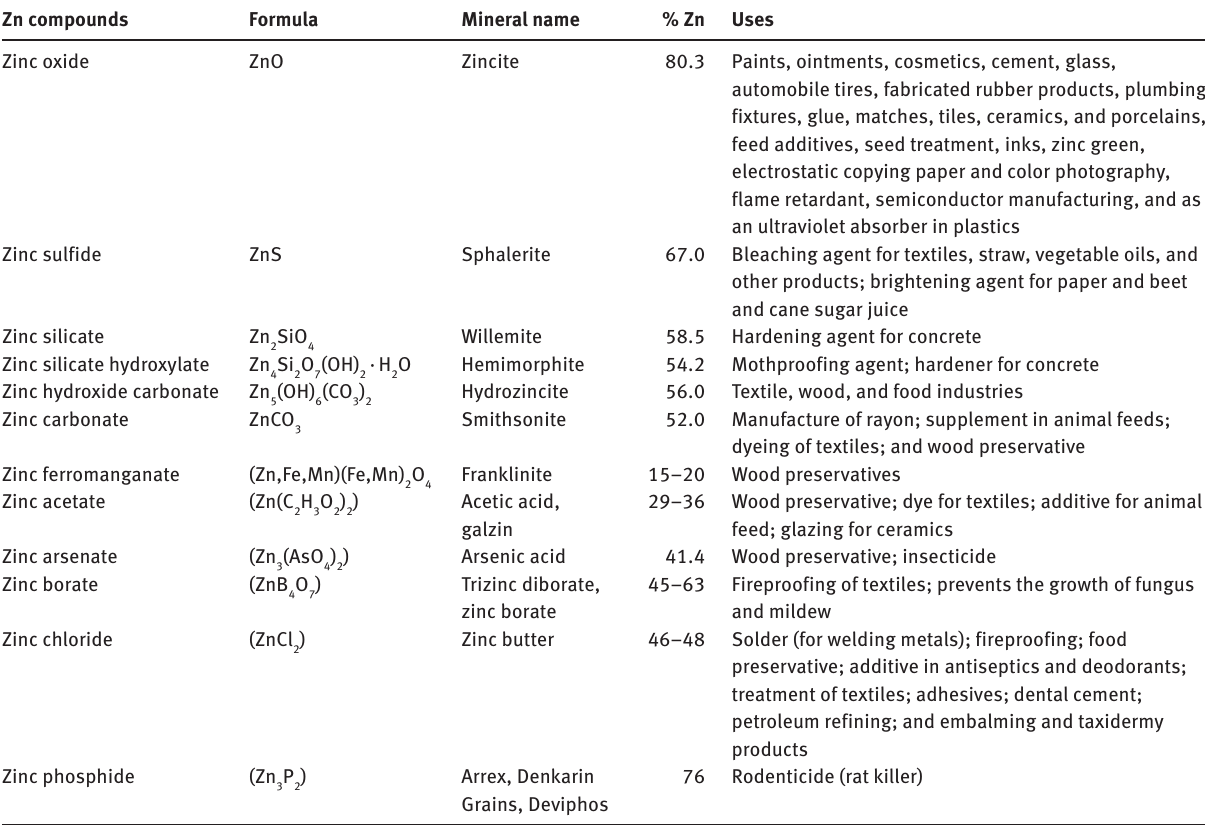
Table 1: Zinc compounds, its percentage, and uses. Zn